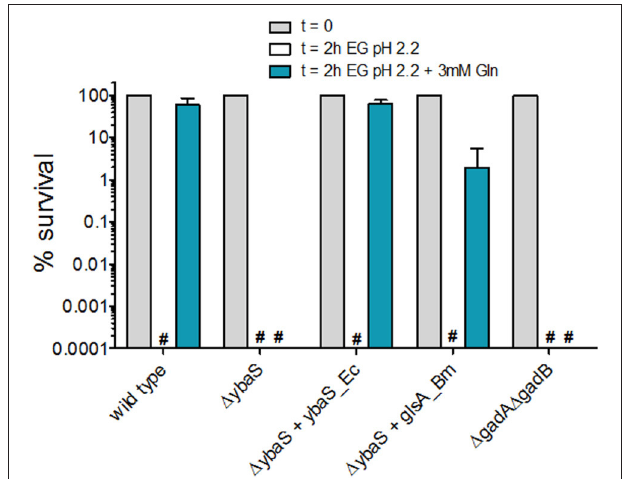
FIGURE 3 | Effect of Gln addition to EG minimal medium at pH 2.2 on the survival of E. coli MG1655 and its isogenic mutant strains. Residual viability of stationary-phase cultures of the indicated strains, diluted 1:4000 in EG pH 2.2 and incubated (statically) for 2h at 37 ◦ C. Following the acid challenge, viability was expressed as % CFU/ml on a log 10 scale, compared to bacteria present at time zero. The data represent the mean (SD) of 3–6 independent experiments. The hashtag indicates no survivors detected. The complemented strains carried the relevant gene cloned into plasmid pBBR1MCS. For consistency, the empty plasmid was also carried by the mutant